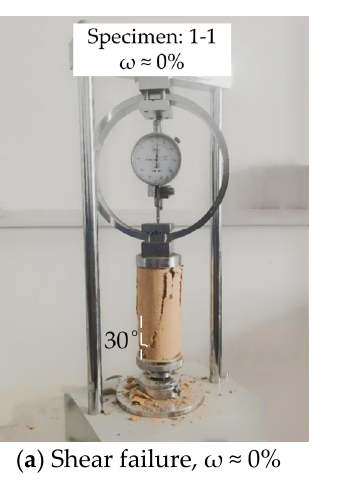
Figure 2. Failure modes from the uniaxial compressive test: ( a ) shear failure with a moisture content of close to 0% and ( b ) tensile failure with a moisture content of 29.18%.